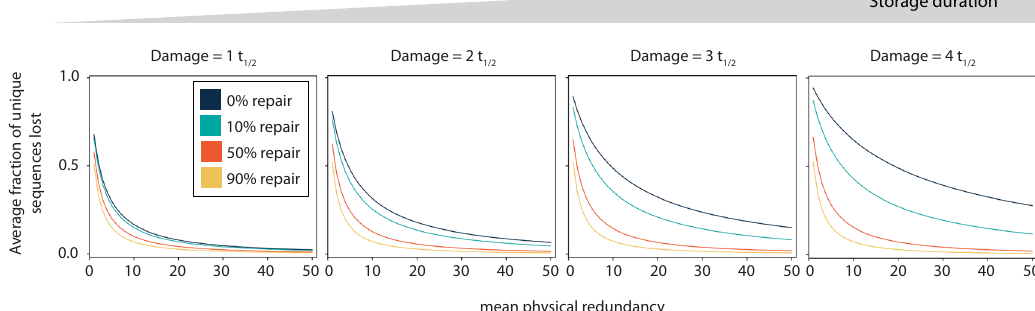
Fig. 5 Simulating damage and repair for high-density storage regimes. For a given physical redundancy and storage horizon (expressed in half-lives of DNA), the data give the fraction of unique sequences lost from the pool during storage (dark blue lines). This loss of sequences has to be compensated by the logical redundancy of an error-correcting code. With DNA repair enabled, a fraction of the lost sequences can be recovered, and less logical redundancy is required. The bene fi ts of DNA repair is the largest in applications with a low physical redundancy and long storage durations, which are target domains for DNA